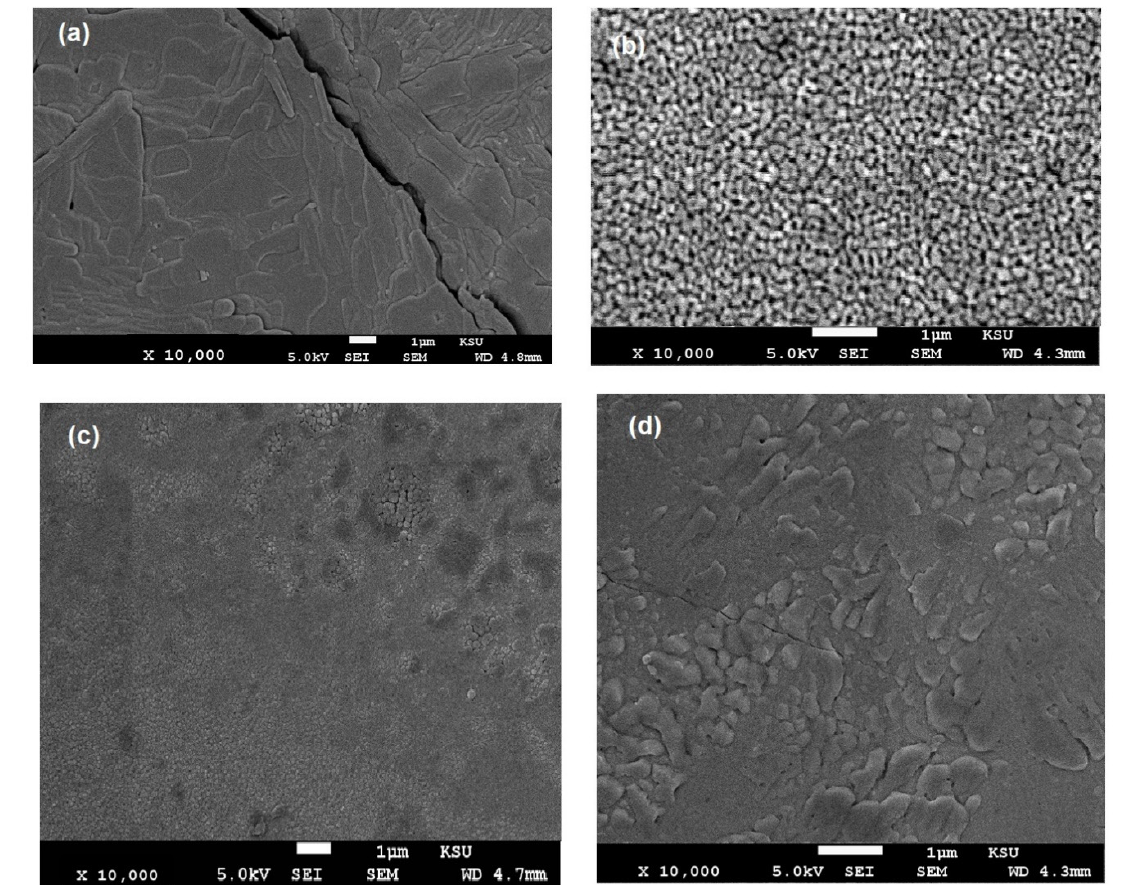
Figure 6. SEM micrographs of DGEB/PA films modified with different Wt. % of HCh-TH2 ( a ) 0, ( b ) 3, ( c ) 6, and ( d ) 10 Wt. %.